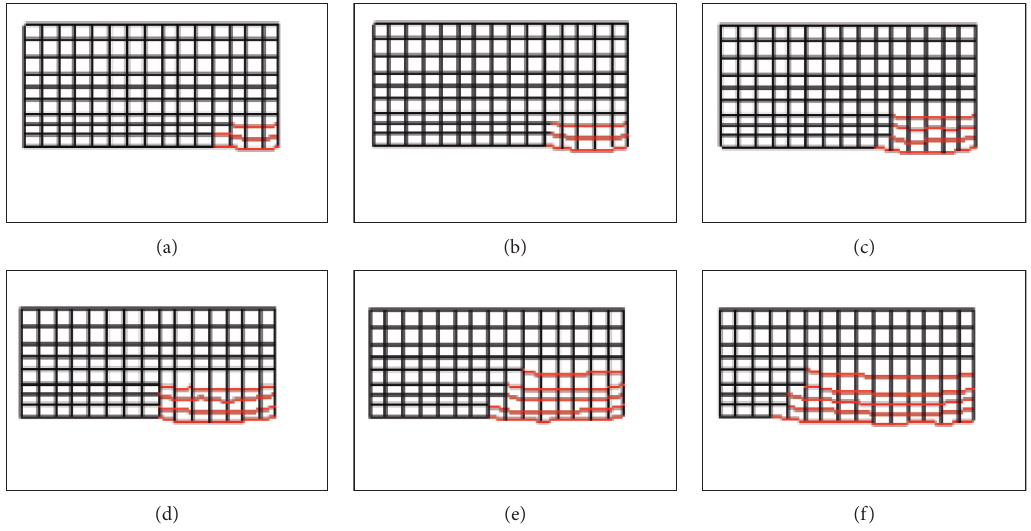
Figure 9: Subsidence map of measuring point with working face of scheme 2. (a) The first periodic pressure. (b) The second periodic pressure. (c) The third periodic pressure. (d) The fourth periodic pressure. (e) The fifth periodic pressure. (f) The eighth periodic